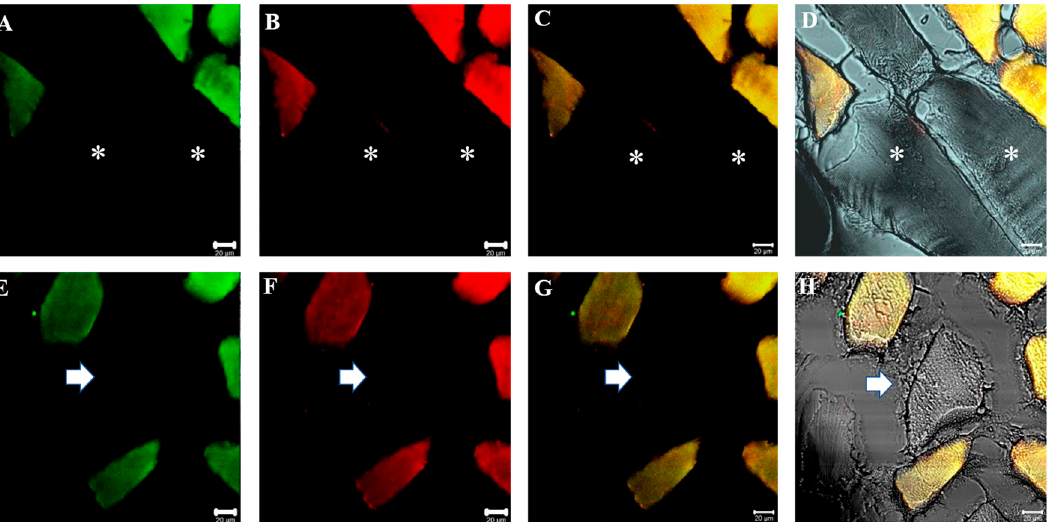
Figure 5. Compound panel of double immunofluorescence reaction between alpha-SG (green channel) and beta-dystroglycan (red channel) ( A – D ) and between gamma-SG and beta-dystroglycan ( E – H ) performed on sternocleidomastoid of low-ranking baboons. Results show the presence of negative fibers for both alpha-SG and beta dystroglycan ( A – D , asterisks) and for both gamma-SG and beta-dystroglycan ( E – H , arrow). Positive and negative fibers are in the same microscopic field as evidenced by transmitted light ( D , H ). The yellow fluorescence arises from the merge between green and red fluorescence. The same data have been found for all the SG isoforms.